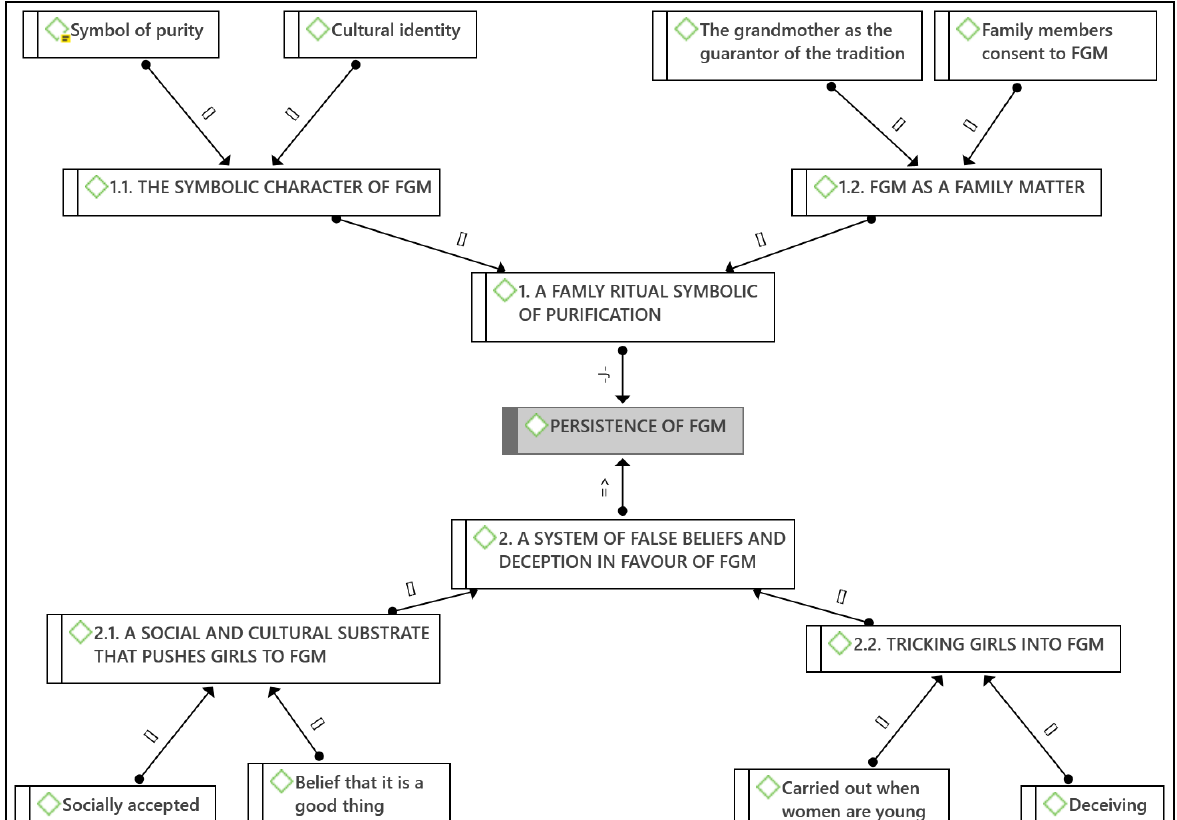
Figure 1. Conceptual map of themes and emerging codes. Key: [] is par of; => is because of; -J- justifies.